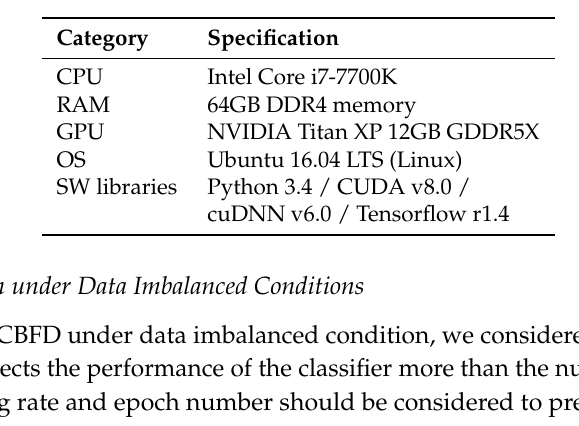
Table 2. Runtime environment